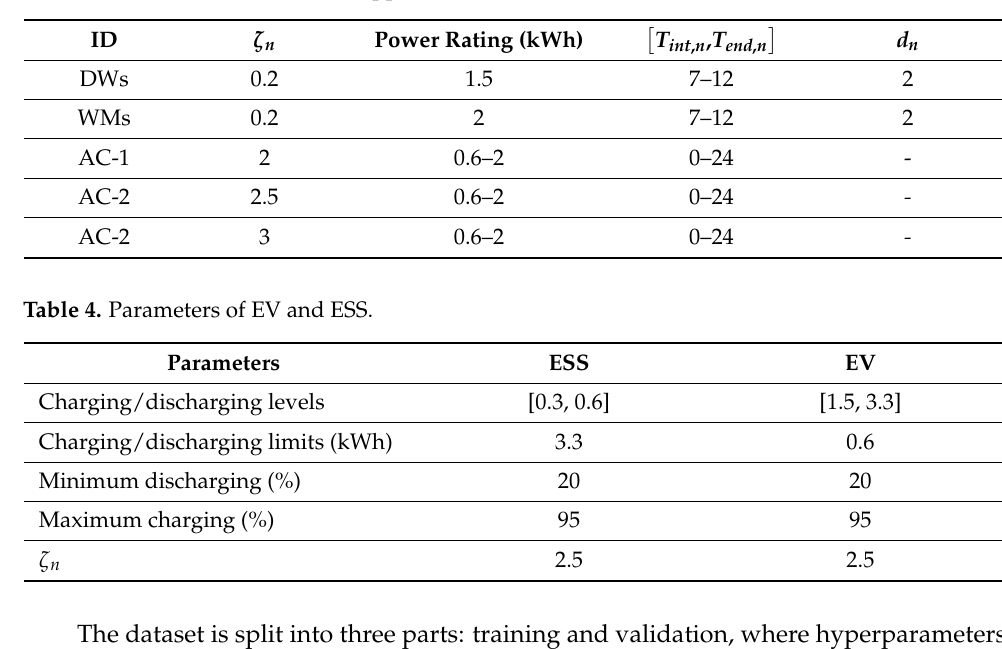
Table 3. Parameters of household appliances.